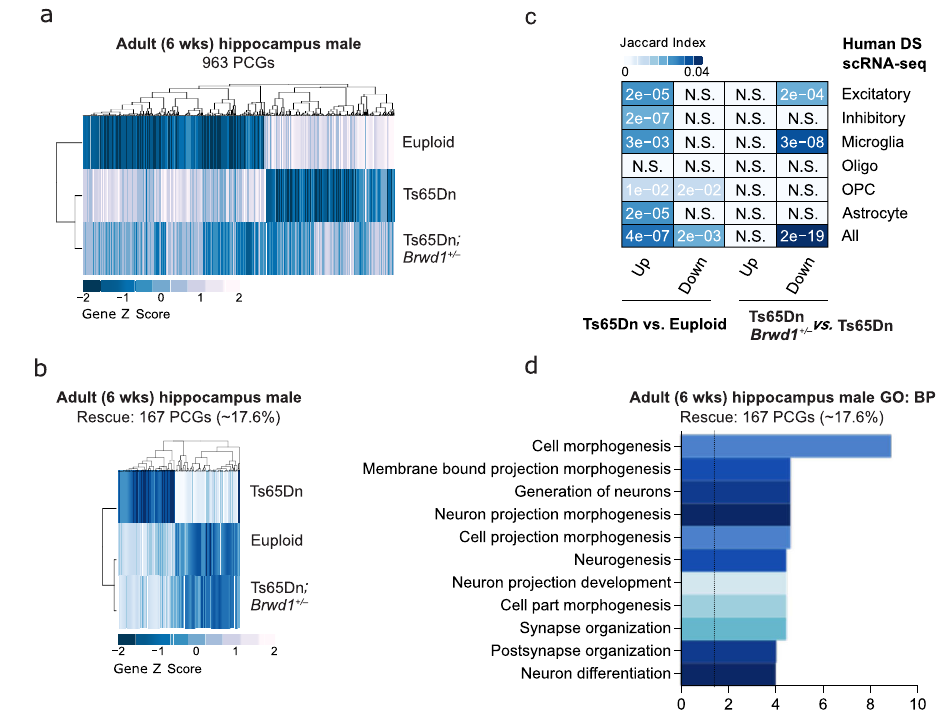
Fig. 2 | Rescue of aberrant gene expression in male trisomic brain by Brwd1 renormalization. a RNA-seq heatmaps of DEgenes comparing euploid vs. Ts65Dn vs.Ts65Dn ;Brwd1 +/ – adultmale(6-week)hippocampus.NormalizedRNAexpression values (averaged between replicates) were used to generate z-scores for each row. b Normalized heatmaps of RNA expression values for DE genes in adult male hip- pocampus thatdisplaypairwisesigni fi cant regulationbetweenTs65Dnvs.euploid, and are rescued in Ts65Dn ;Brwd1 +/ – vs. Ts65Dn. c Heatmap displays Jaccard